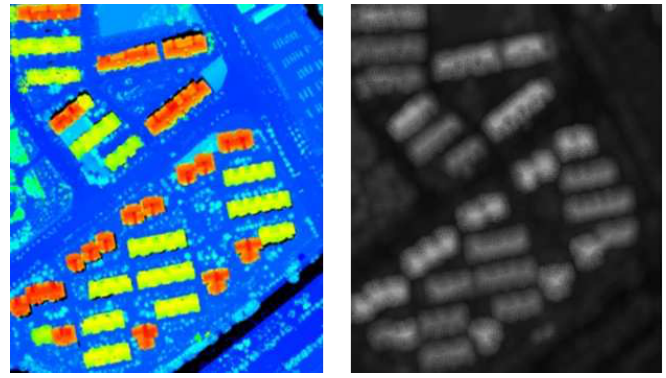
Figure 1. Point cloud rendering image (left) and elevation map